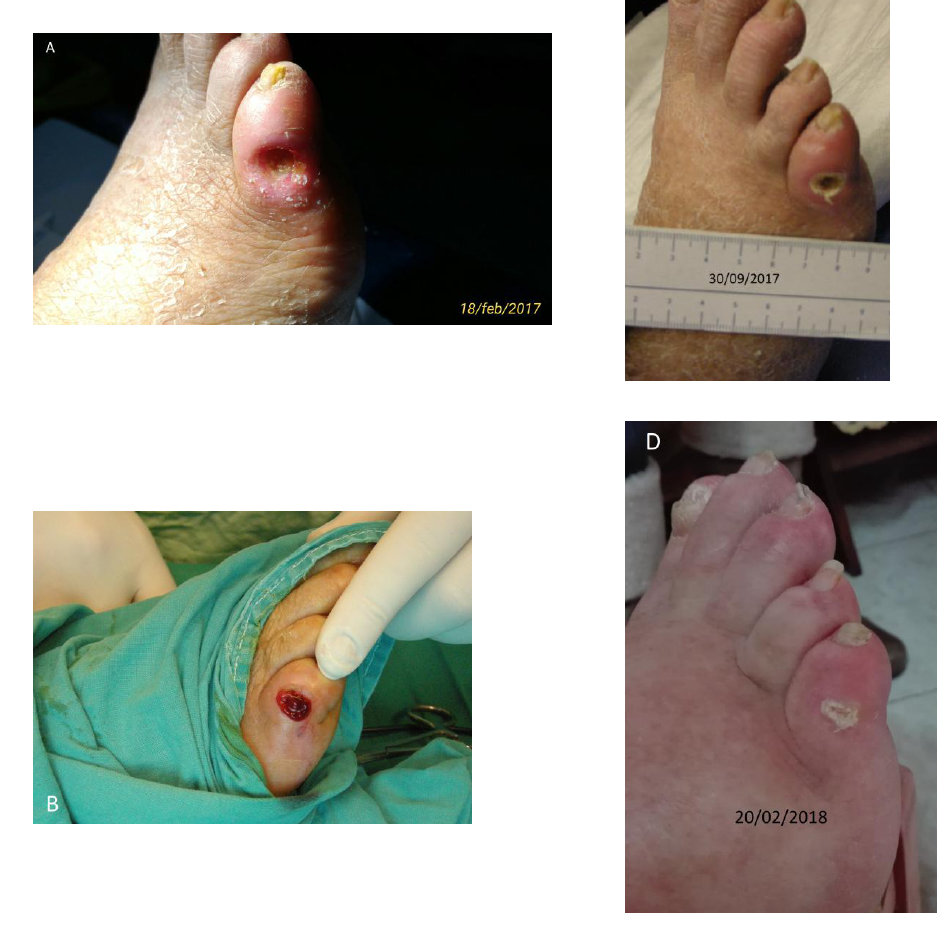
Figure 2. Case No. 2. ( A , C , D ) Different moments of the wound healing, stable after one year; ( B ) The lesion after L-PRF grafting.